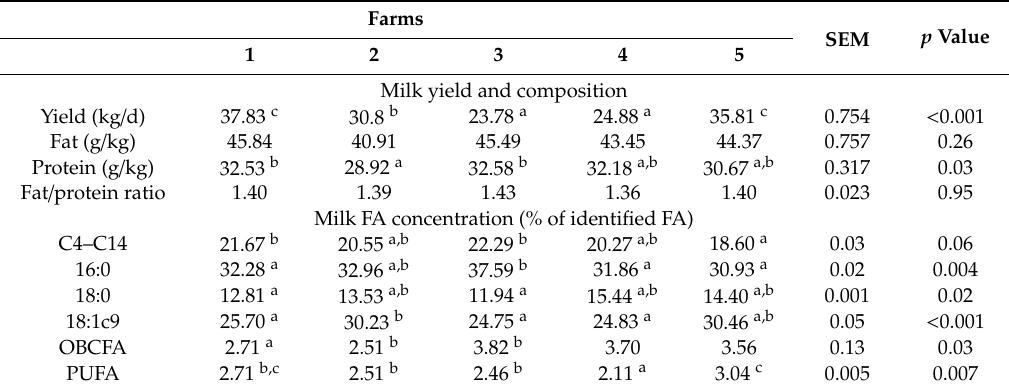
Table A1. LS means of milk yield and composition and fatty acid concentrations in early lactation Holstein cows in the 5 farms of the study.